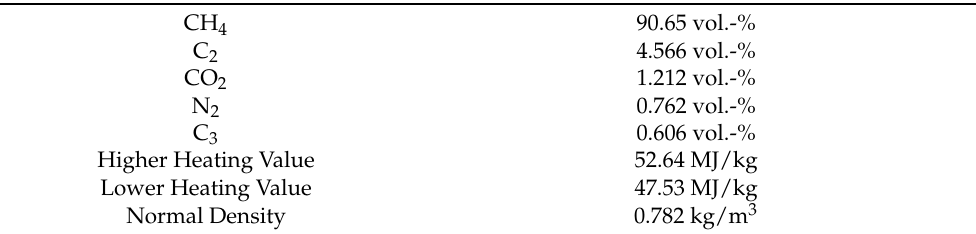
Table 2. Main components and characteristics of the fuel.